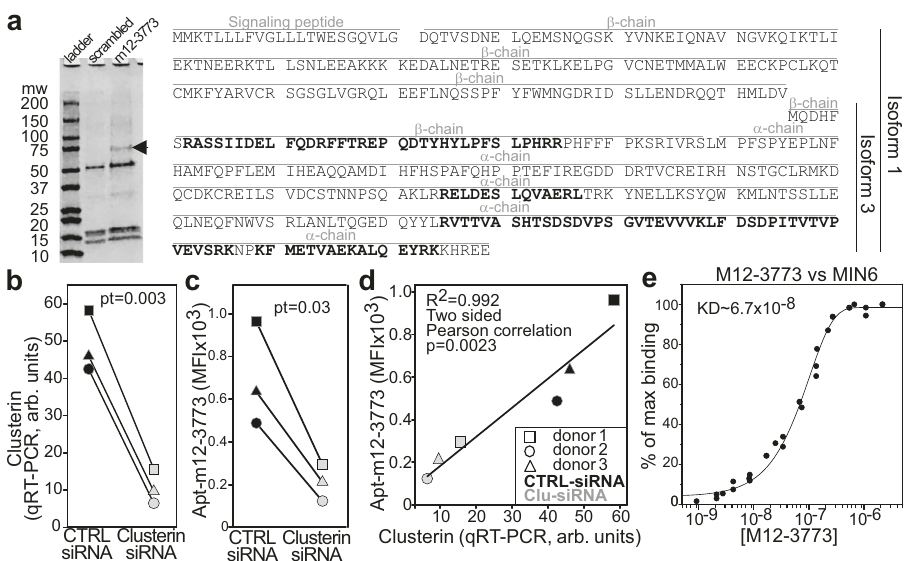
Fig. 3 Clusterin is the putative target for aptamer m12-3773. a Single-cell suspension from human islets was incubated with biotinylated aptamer m12- 3773 or scrambled aptamer, cell membrane lysed, and aptamer ligand complexes were isolated with magnetic beads conjugated with streptavidin. Captured proteins underwent SDS page and Coomassie blue staining. The differentially expressed band from m12-3773 (arrow) or the corresponding gel area from the scrambled immune precipitate was extracted and analyzed by mass spectrometry. Peptides identi fi ed by the Mascott software are in bold in the clusterin sequence. One experiment representative of other two is shown. b Non-dissociated human islets were transfected with aptamer-chimera composed of aptamer 1-717 and either siRNA speci fi c for clusterin or scrambled siRNA. Clusterin expression was evaluated 72 h later by qRT-PCR. Two sides paired. T test was performed. c Islets from ( b ) were dissociated, stained with cy3-aptamer m12-3773, and antibodies against insulin and glucagon. MFI after gating on viable insulin-positive cells is shown. Two sides paired. T test was performed. d Expression of clusterin evaluated via qRT-PCR ( b ) was plotted against the MFI of m12-3773 on β cells ( c ). e Af fi nity. MIN6 cells were stained with vital dye and different concentrations m12-3773 aptamer- chimera annealed with cy5-labeled guide saRNA and analyzed by fl ow cytometry. Source data are provided as a Source Data fi